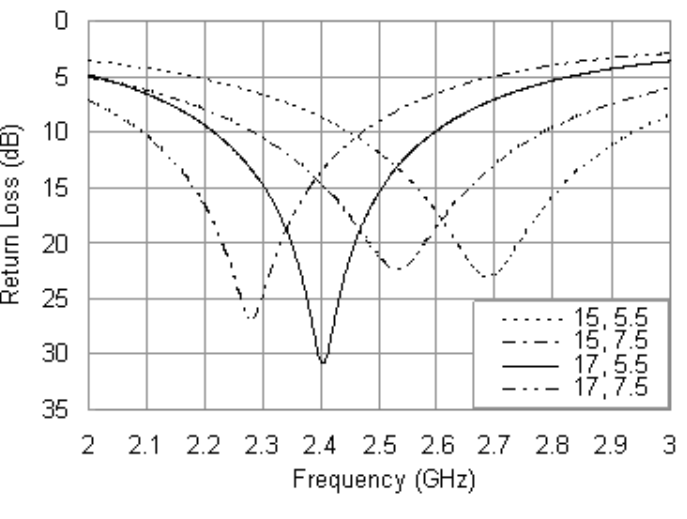
Figure 3. Simulated return loss curves with different values of R